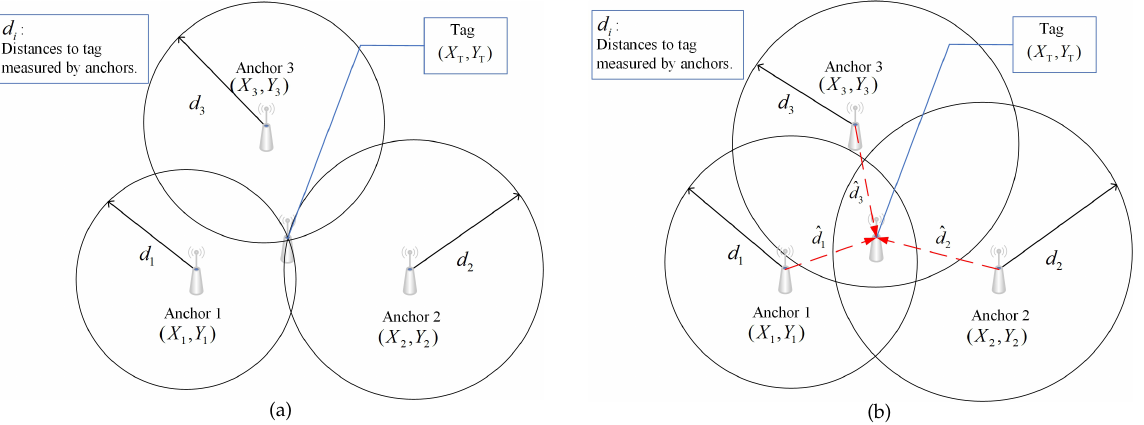
Figure 2. Different quality positioning result. ( a ) High-quality positioning result; ( b ) low-quality positioning